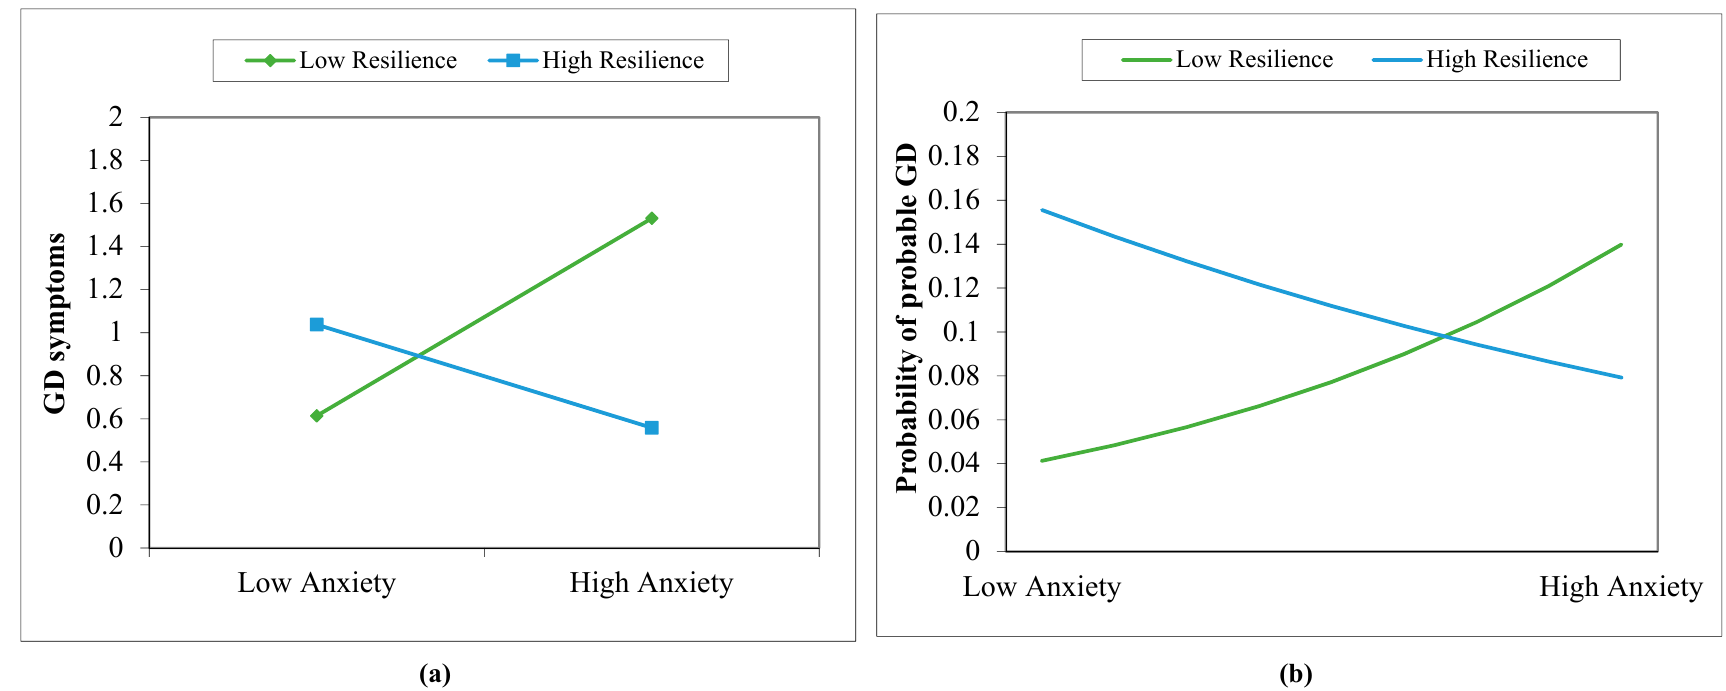
Figure 1. Moderating effects of psychological resilience on the relationship between anxiety and ( a ) GD symptoms and ( b ) probable GD. The focal variables of anxiety symptoms and resilience were mean ‐ centered and adopted +1SD as the high point and –1SD as the low point, respectively.